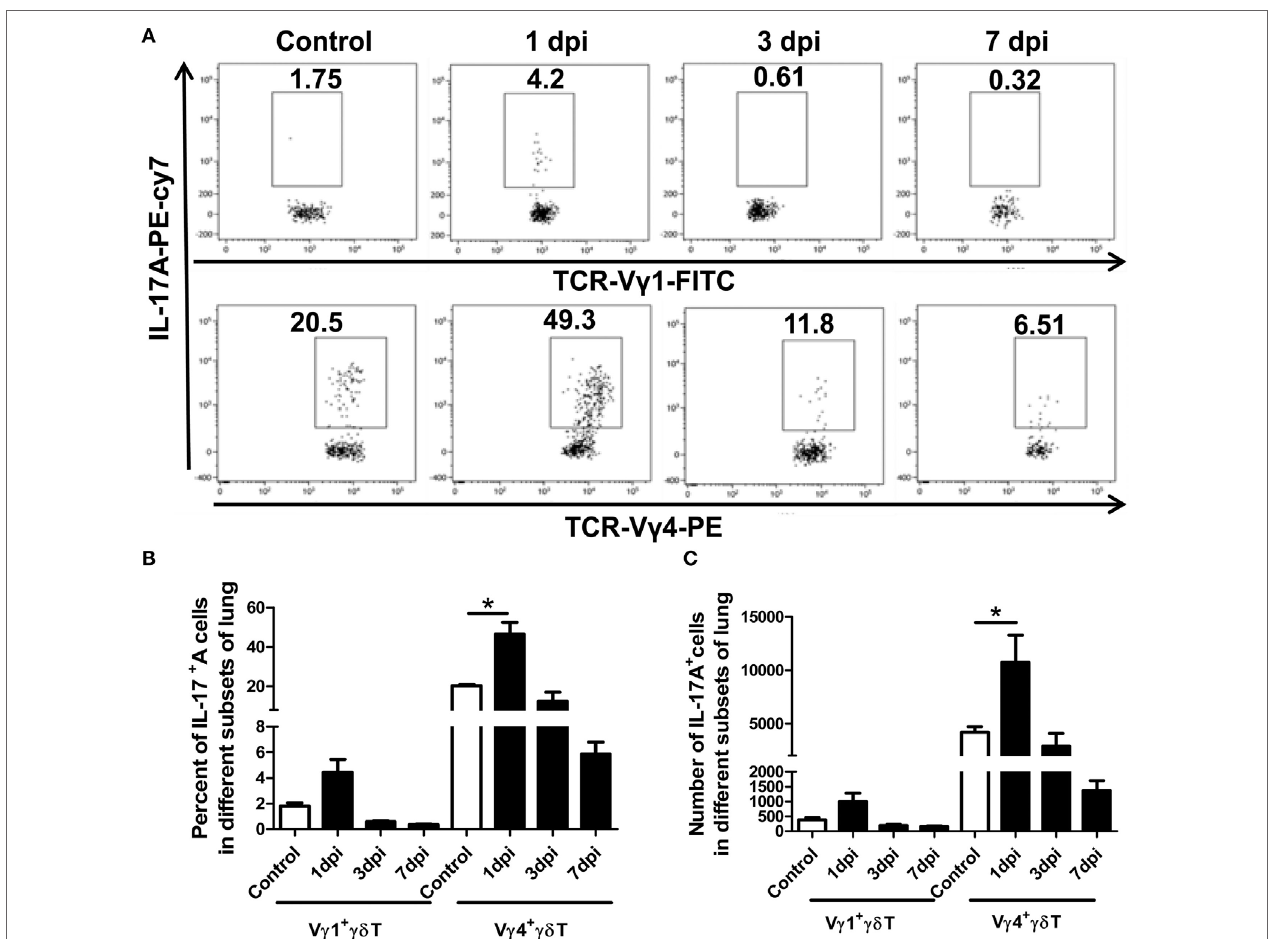
FigUre 3 | Expression of IL-17A in the V γ 1 + γδ T and V γ 4 + γδ T subsets. (a) Stained lung lymphocytes were first gated on CD3 + γδ TCR + cells, and then the expression of IL-17A in the V γ 1 + γδ T subset (upper) and V γ 4 + γδ T subset (lower) in the control or infected lungs at the indicated dpi was analyzed. The numbers represent the proportion of IL-17A-positive cells among the different subsets at the indicated dpi. Histogram showing the changes in the proportion (B) and number (c) of IL-17A-positive cells among the V γ 1 + γδ T and V γ 4 + γδ T subsets in the control or infected lungs at different dpi. The results are representative of two independent analyses ( n = 3 for each group). * p <